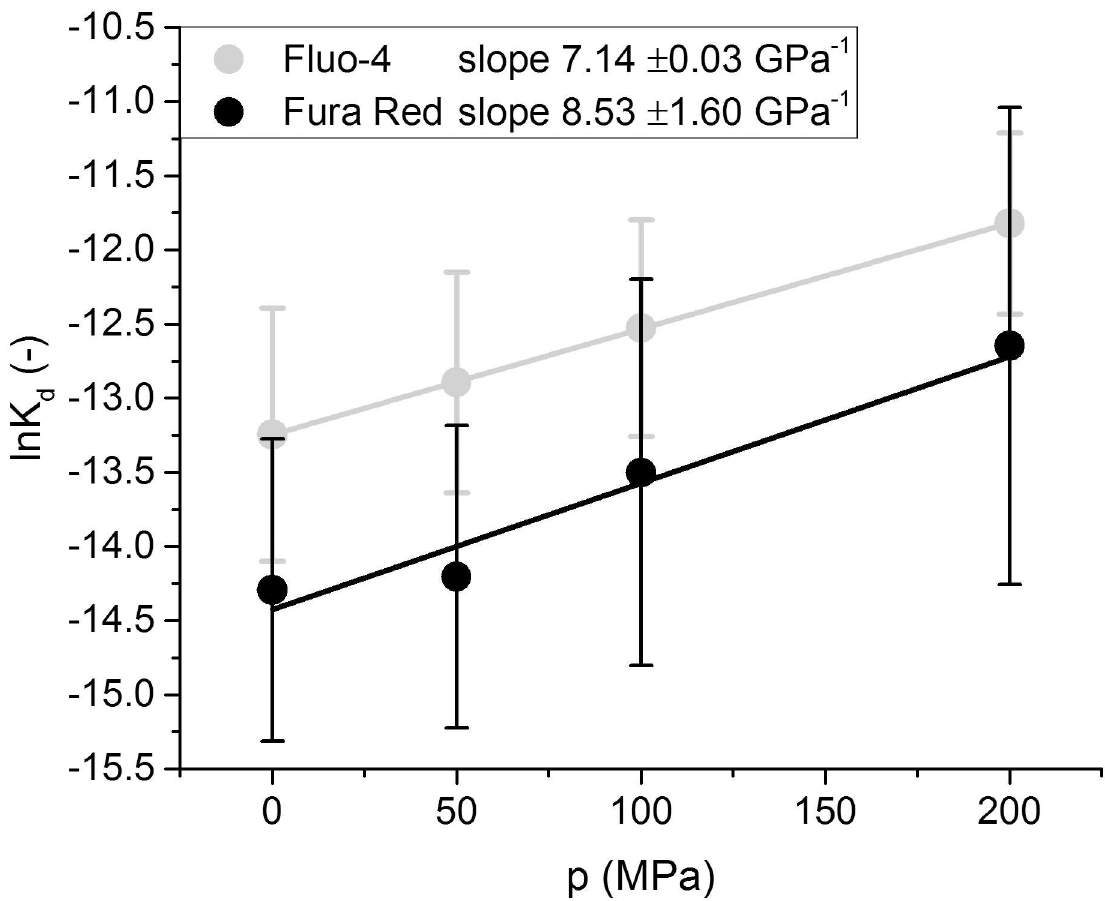
Fig 8. Pressure-dependence of the dissociation constant K d . The mean ln K d is plotted against hydrostatic pressure p for Fluo-4 and Fura Red, the standard deviationis shown as error bars and the number of observations n is 3 for Fura Red and 4 for Fluo-4. The slope θ of the linear fit to the data was used to determine the average molar volume change for the dissociation reaction Δ d v by using Eq